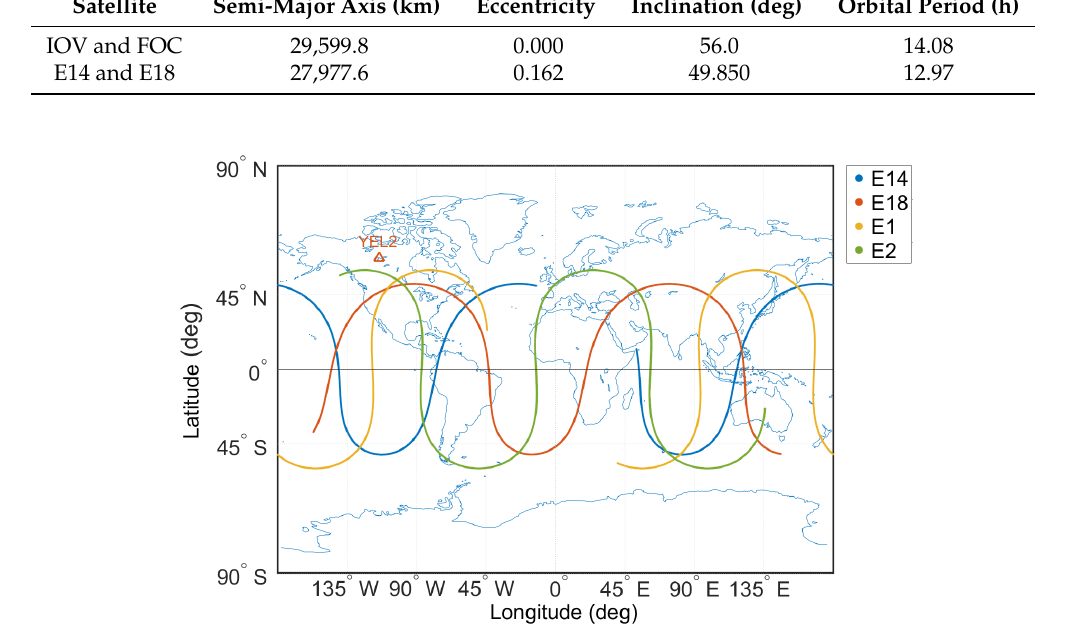
Figure 1. Ground tracks of the Milena (E14), Doresa (E18), E1, and E2 Galileo satellites depicted in blue, red, yellow, and green, respectively, on DOY 52 2018. In the figure, for better readability, only four satellites are